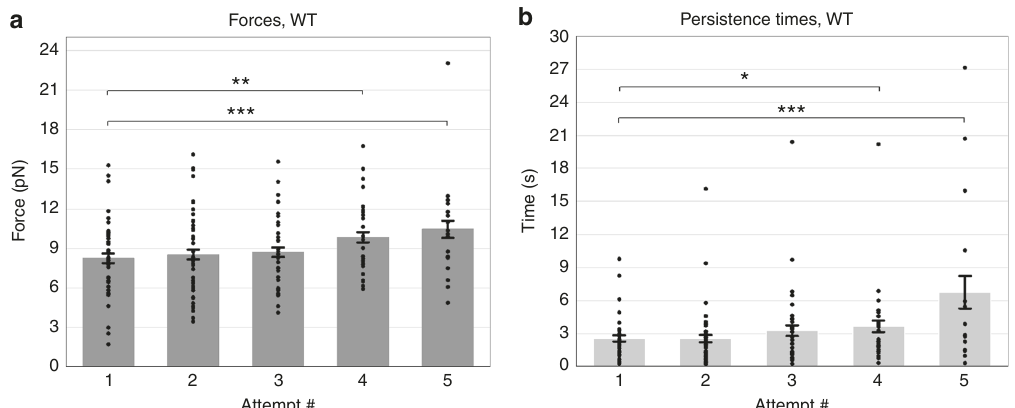
Fig. 1 Minus-end forces and persistence times increase when dynein-driven LD cargo are under load. Average peak forces for minus-end moving LDs show slight increase in WT background ( a ). Average persistence times for dynein-driven LDs show signi fi cant increase in WT background ( b ). Quanti fi ed data represent the mean ± s.e.m. of n = 5 independent experiments. T test P values * P < 0.05, ** P < 0.01, *** P